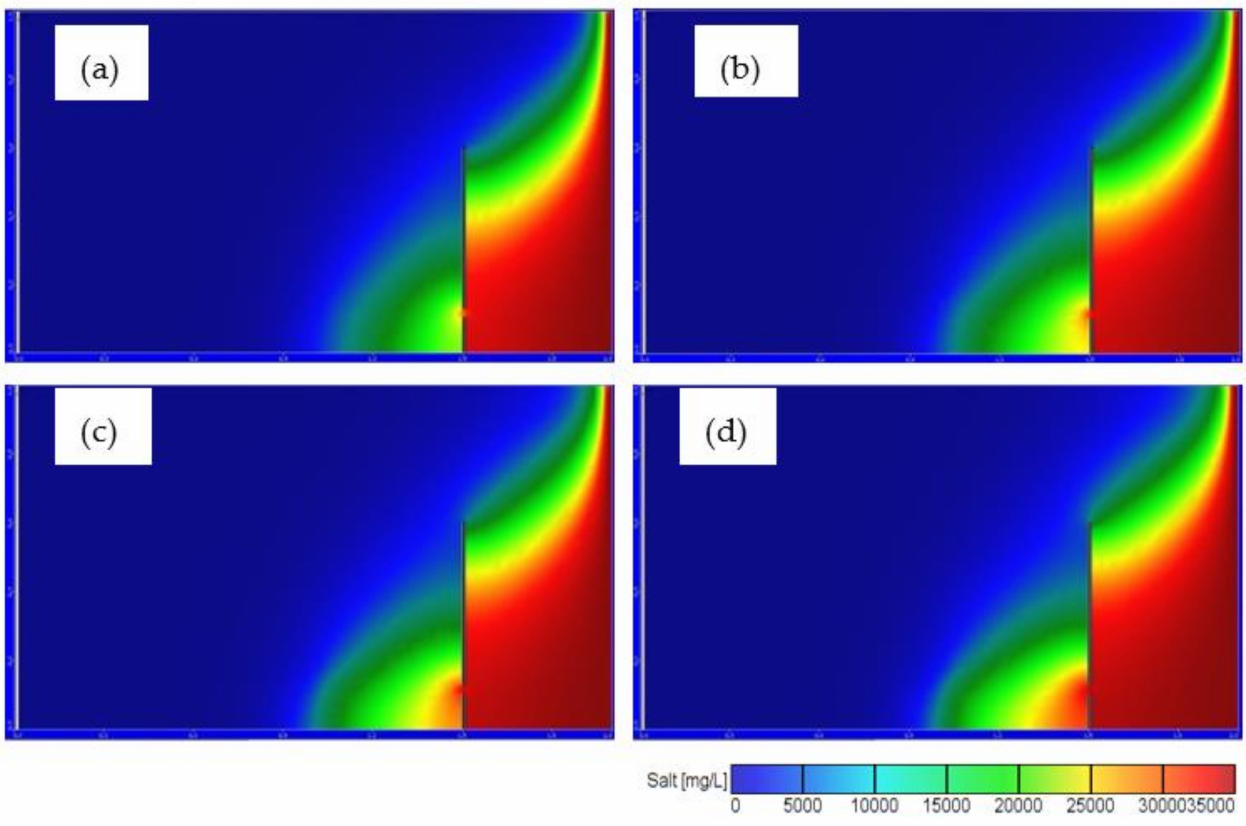
Figure 17. Salinity distribution for D F = 0.01 m, L d = 0.5 m, H w /H d = 0.25 for fracture height H f = 0.1 m and for different values of abstraction rates: ( a ) 2 × 10 − 6 ( b ) 3 × 10 − 6 , ( c ) 4 × 10 − 6 , and ( d ) 5 × 10 − 6 m 3